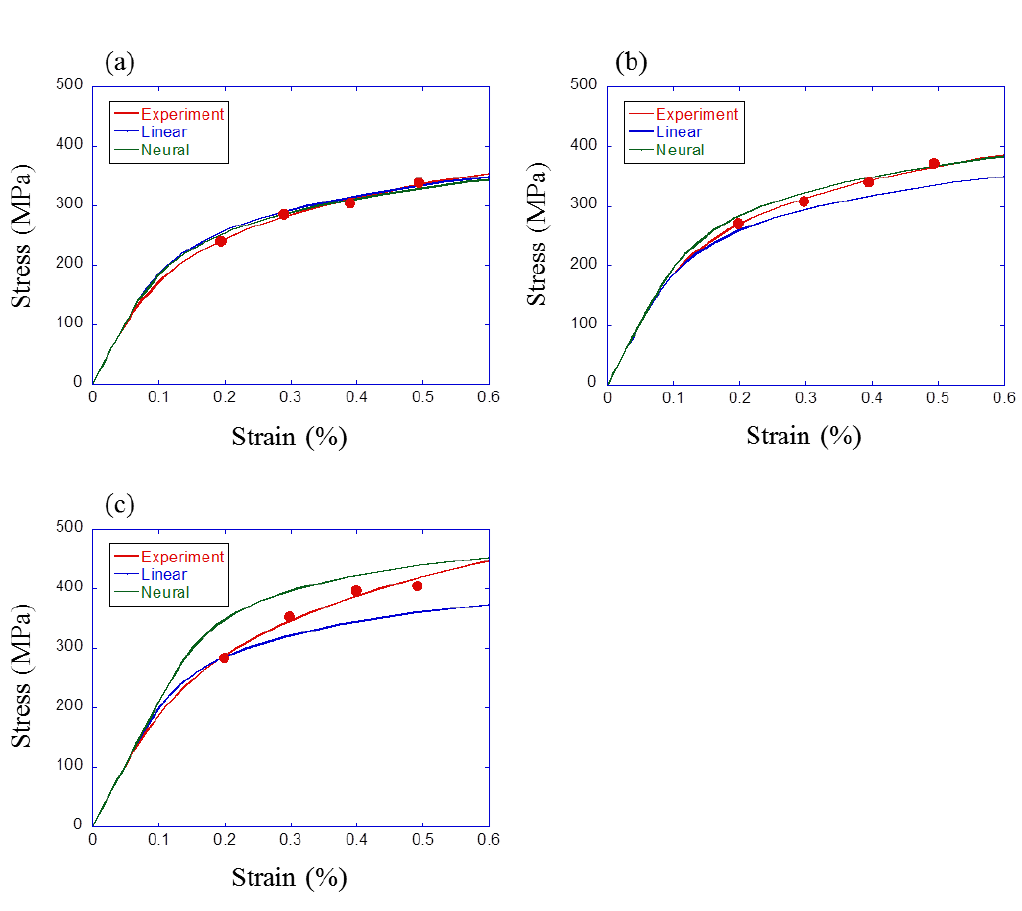
Figure 15. Comparison results between machine learning and experiment for ( a ) S25C, ( b ) S35C, and ( c ) S45C.